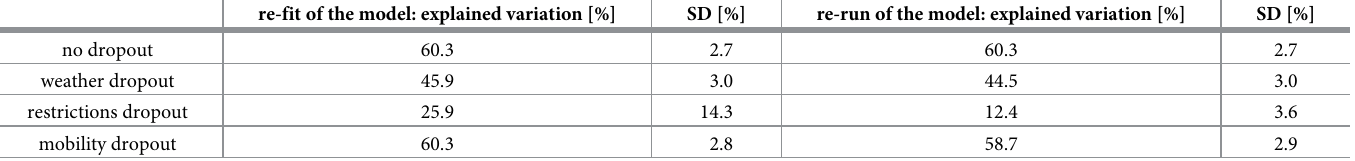
Table 3. Result of the re-fit and re-run with variable group dropout for investigation of impact of the different variable groups on explained variation. re-fit of the model: explained variation [%] SD [%] re-run of the model: explained variation